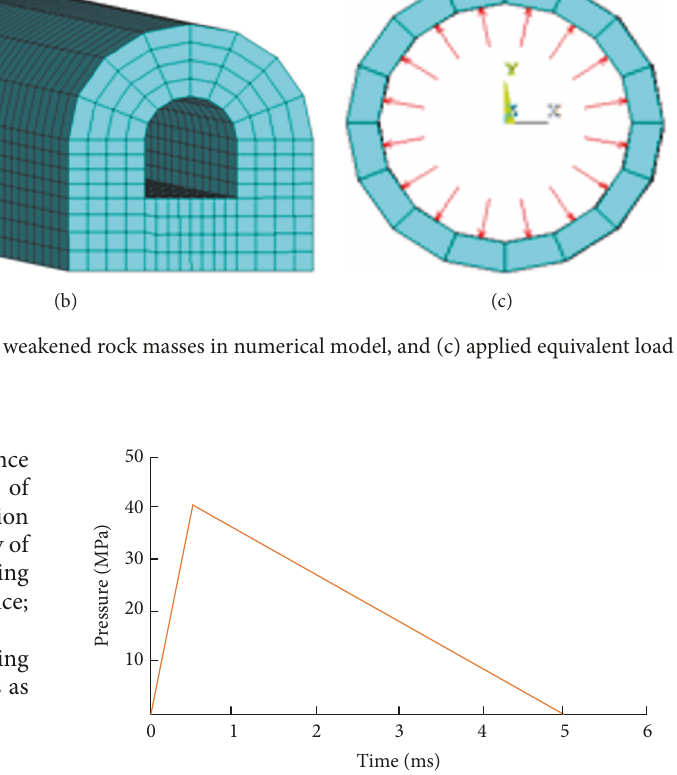
Figure 4: Numerical simulation inversion of the equivalent trian- gular